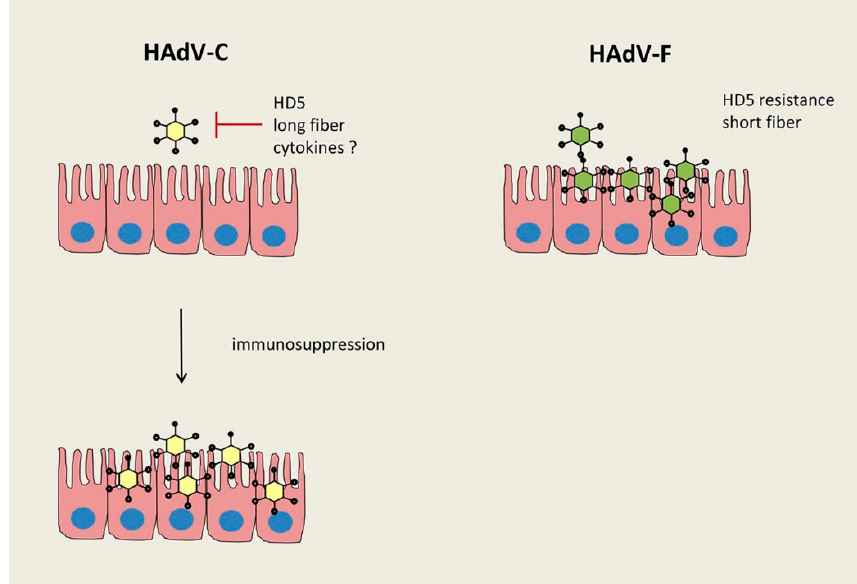
Figure 1. Different regulation of intestinal HAdV infections by species C and F. The production of HAdV-C types is regulated by human defensin 5 (HD5), whereas HAdV-F types are resistant to HD5, secreted by intestinal Paneth cells. A higher stability of the short fiber protein on HAdV-F types is suggested to also play a role for the frequent gastrointestinal tract infection by these species. Another important regulation might be due to specific cytokines (e.g., IFN α , β , γ , or λ ) and their antiviral capacity.